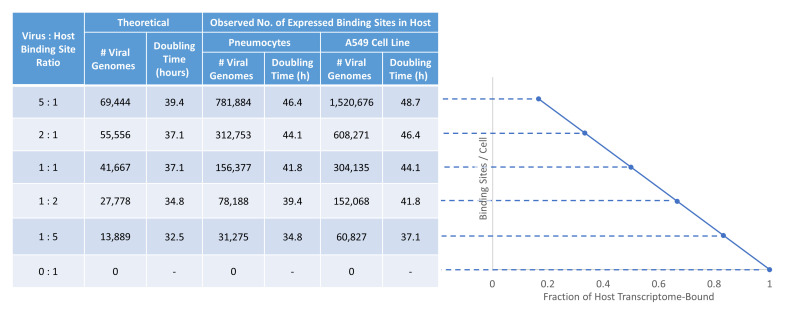
Inhibition of Host SRSF1 Binding by Viral Genome Replication.As the fraction of SARS-CoV-2 genomes increase in the host cell, the fraction of SRSF1 bound to the host transcriptome versus the viral genome decreases, resulting in R-loops. Strong SRSF1 binding sites (“Replicate 2” model) were identified in both SARS-CoV-2 (N=60 on the positive strand) and in the human transcriptome. A Scatchard plot (right) was created and used to determine the theoretical number of viral SRSF1 binding sites expected at different viral genome (inhibitor) to host (substrate) ratios (left).